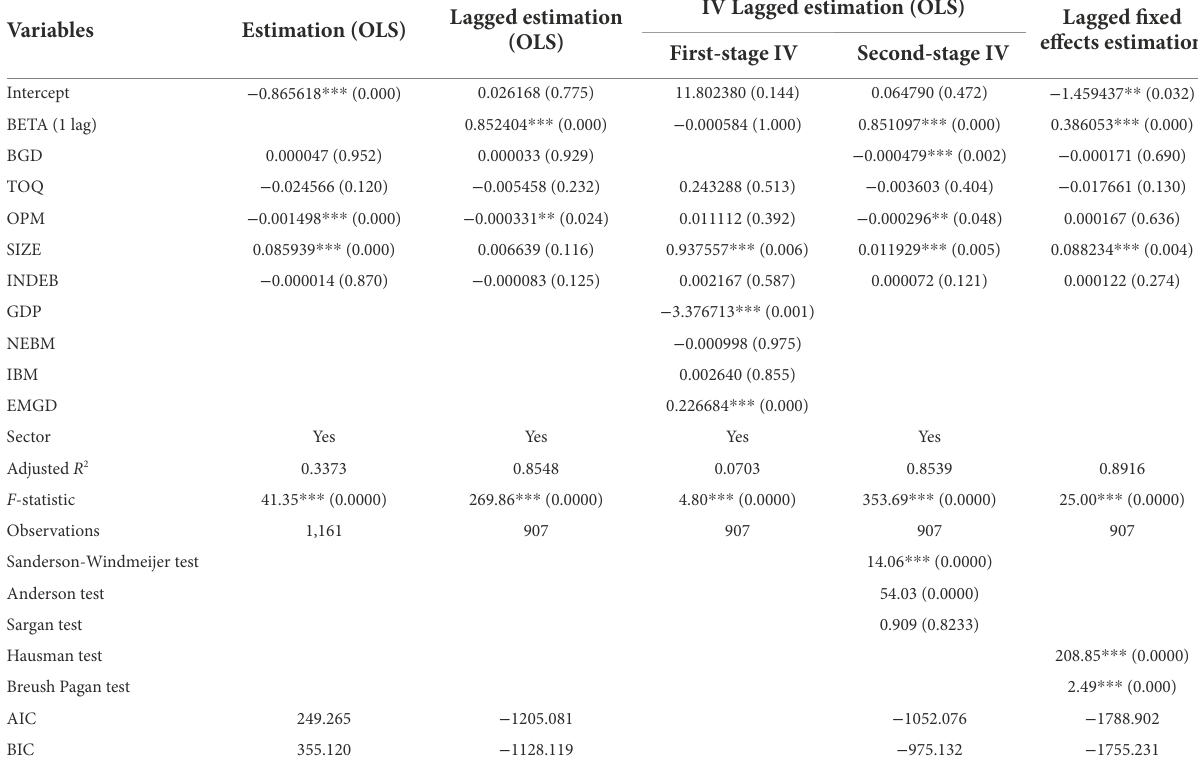
TABLE 9 Regressions in the EU